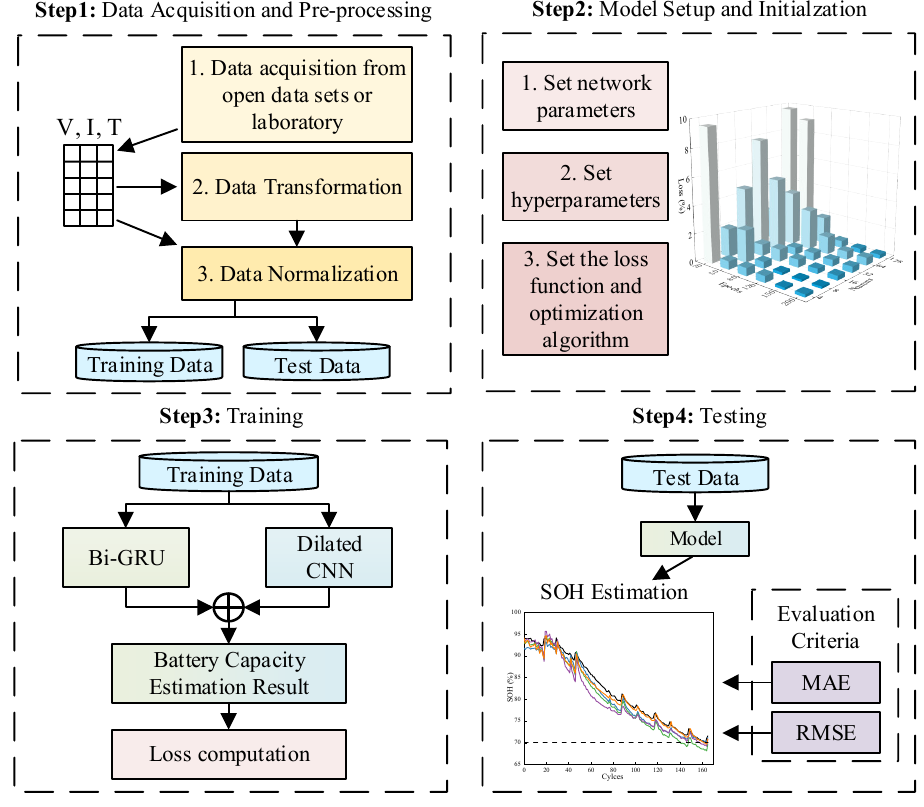
Figure 6. The flowchart of proposed SOH estimation algorithm.